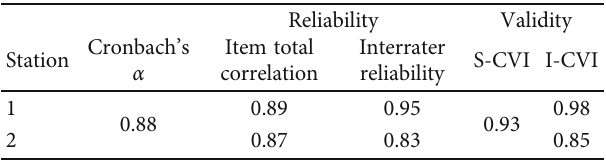
Table 2: Reliability and validity of the situated simulation-based exam.